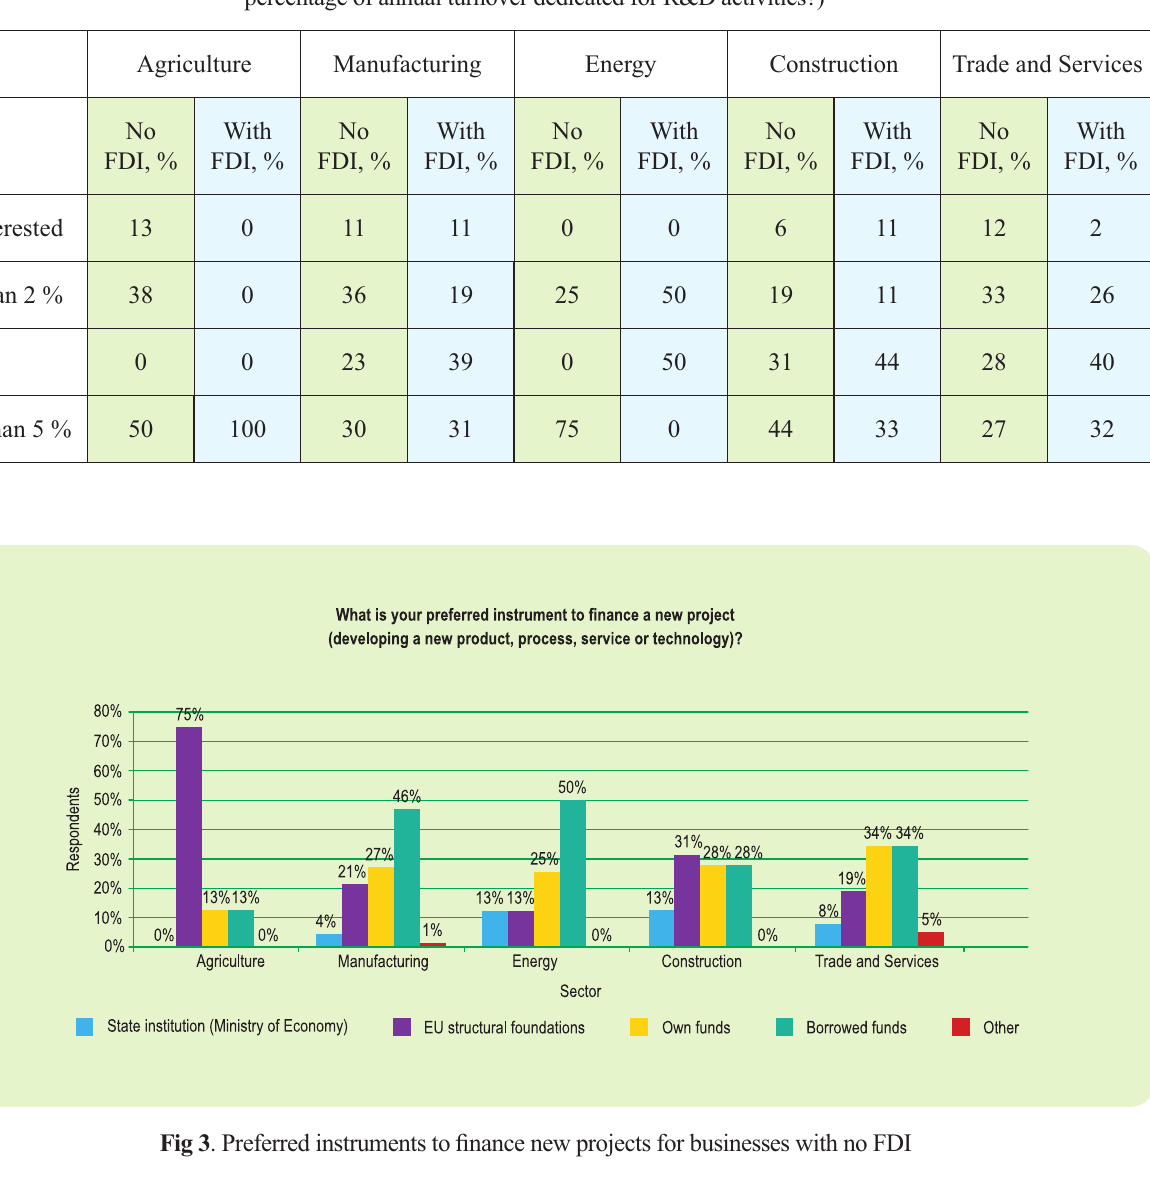
Table 1. Percentage of dedicated funds for Research and Development activities for businesses with and without FDI (What is the percentage of annual turnover dedicated for R&D activities?)